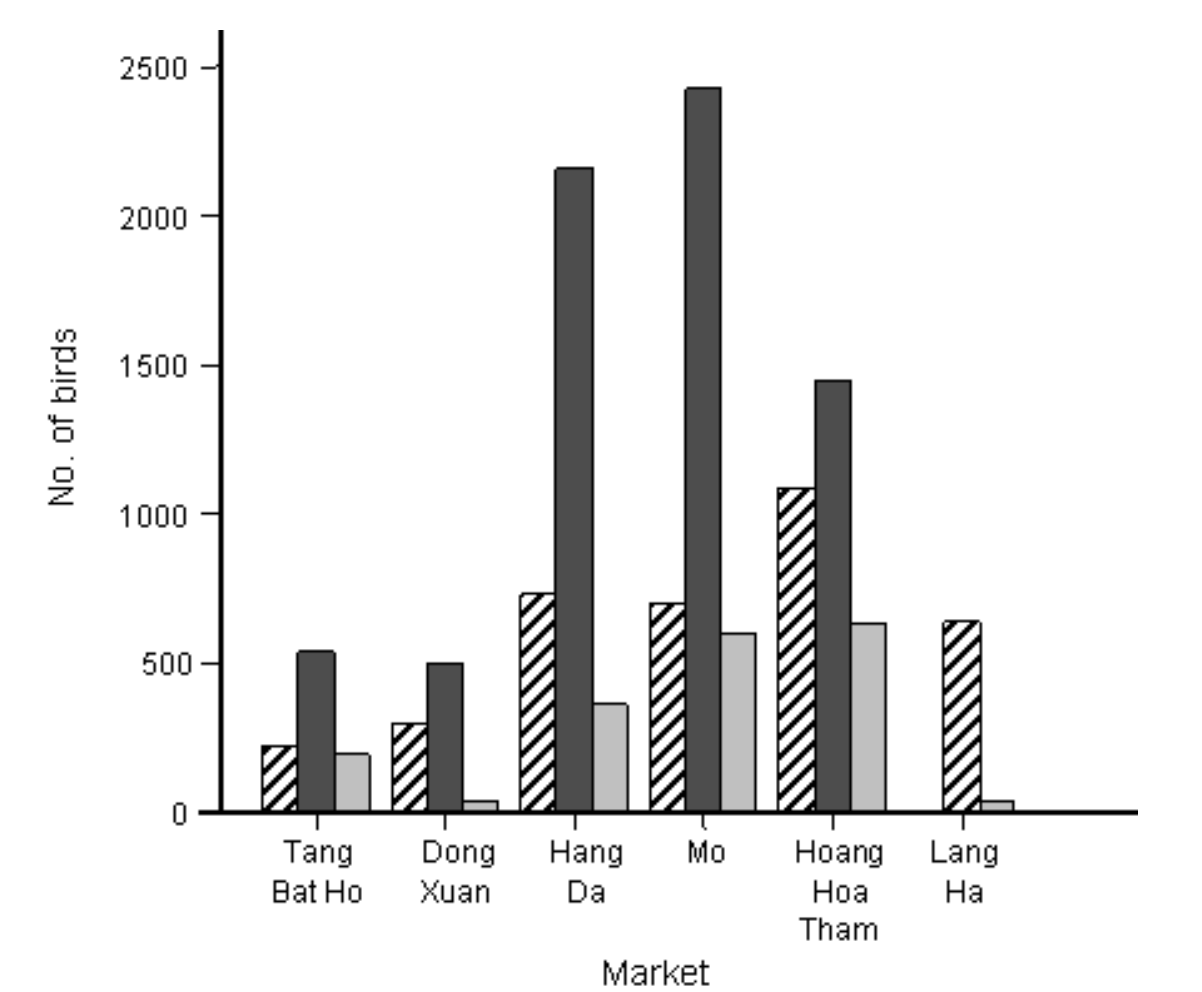
Fig. 2 . The number of birds recorded in each Hanoi bird market during the 2000 (in stripes), 2003 (in black), and 2007 (in grey)